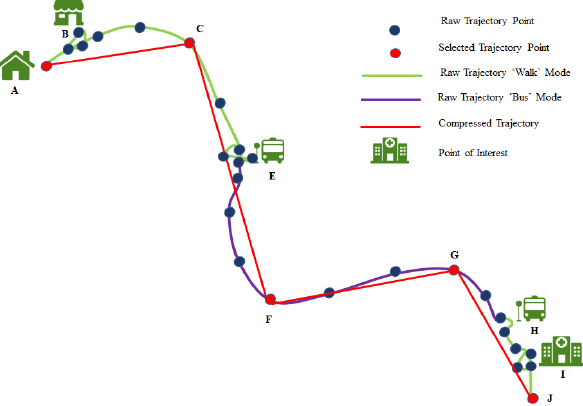
Figure 2 . Constant threshold